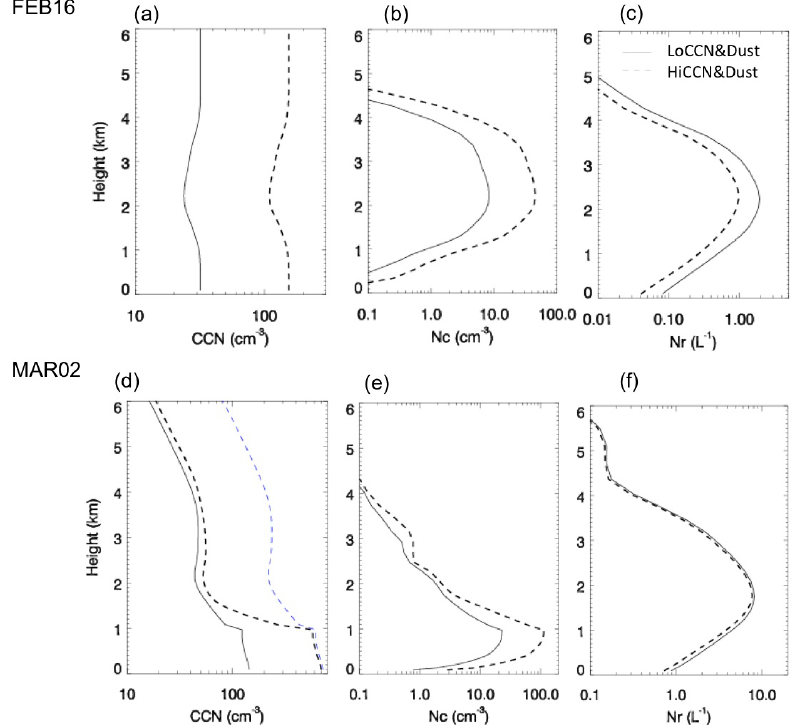
Fig. 12. Vertical profiles of CCN, N c , and N r from LoCCN&Dust (black solid line) and HiCCN&Dust (black dashed line) for FEB16 (a, b, c) and MAR02 (d, e, f) . The red line denotes a sensitivity run that is based on HiCCN&Dust but with polluted CCN concentrations at the southern and western boundaries. The data are averaged over the regions where the elevated CCN are applied in HiCCN&Dust (i.e., land with sea levels <200 m) during 00:00–23:00UTC. The dashed blue line in (d) for MAR02 denotes the increase of CCN from base-run conditions (black line) by 5